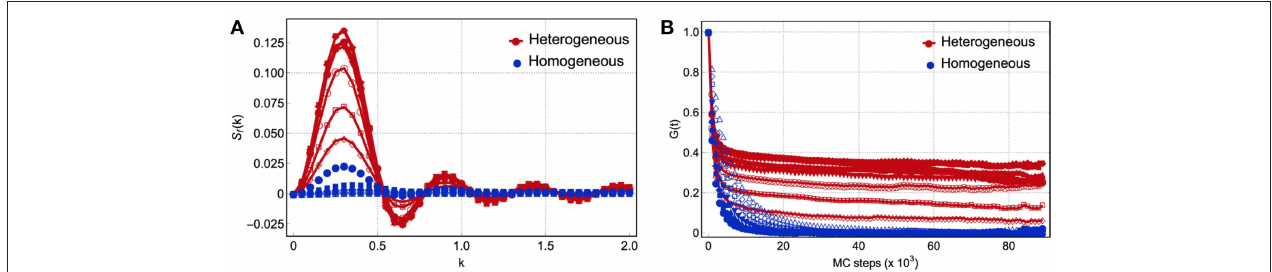
FIGURE 4 | (A) Spatial correlation function and (B) time correlation function for N = 576. Red curves correspond to temperatures T ( m ) = 10 / 2 m with m = { 0,...,5 } and blue curves correspond to temperatures T ( m ) with m = { 6,...,16 } . The blue open symbols correspond to temperatures T . α , i.e., of the order of the weak interactions. The wavenumber k has been averaged over three different directions. The time correlation function was computed using samples taken every 10 3 Monte Carlo